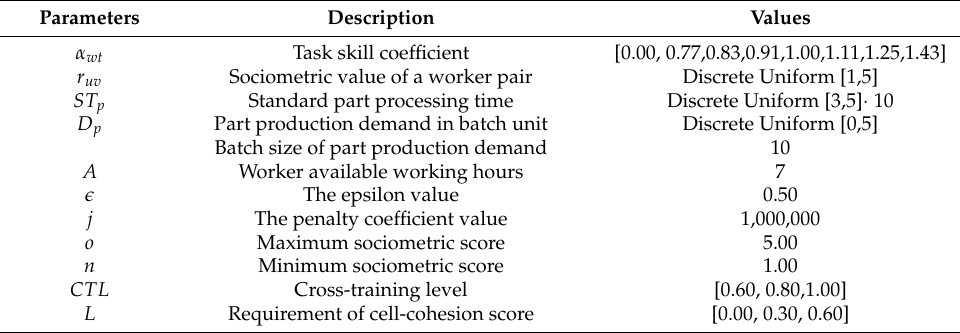
Table 14. Summary of the model input